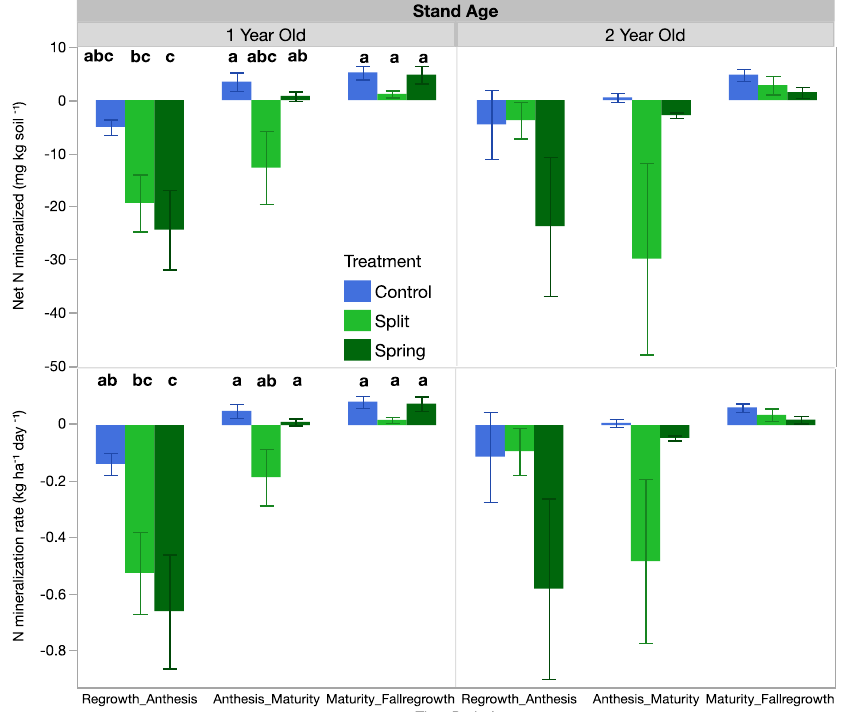
Figure 6. Net mineralized N and the N-mineralization rate of 1-year-old and 2-year-old intermediate wheatgrass fields across sampling times and nitrogen fertilization. Within treatments in each field, bars with the same or no letter are statistically similar as per Tukey’s HSD ( p = 0.05). Control = 0 kg N ha −1 ), split = 40–40 kg N ha −1 , and spring = 80 kg N ha −1.